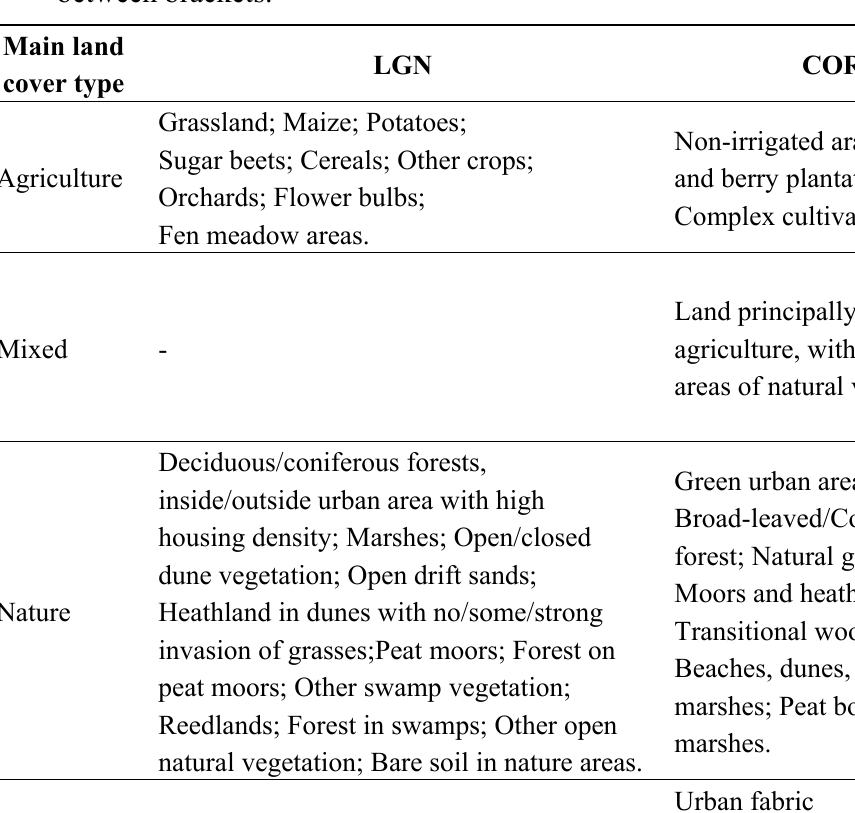
Table 2. Classifications of land cover maps into main land cover types. For the mixed land cover types, the percentage nature is given between